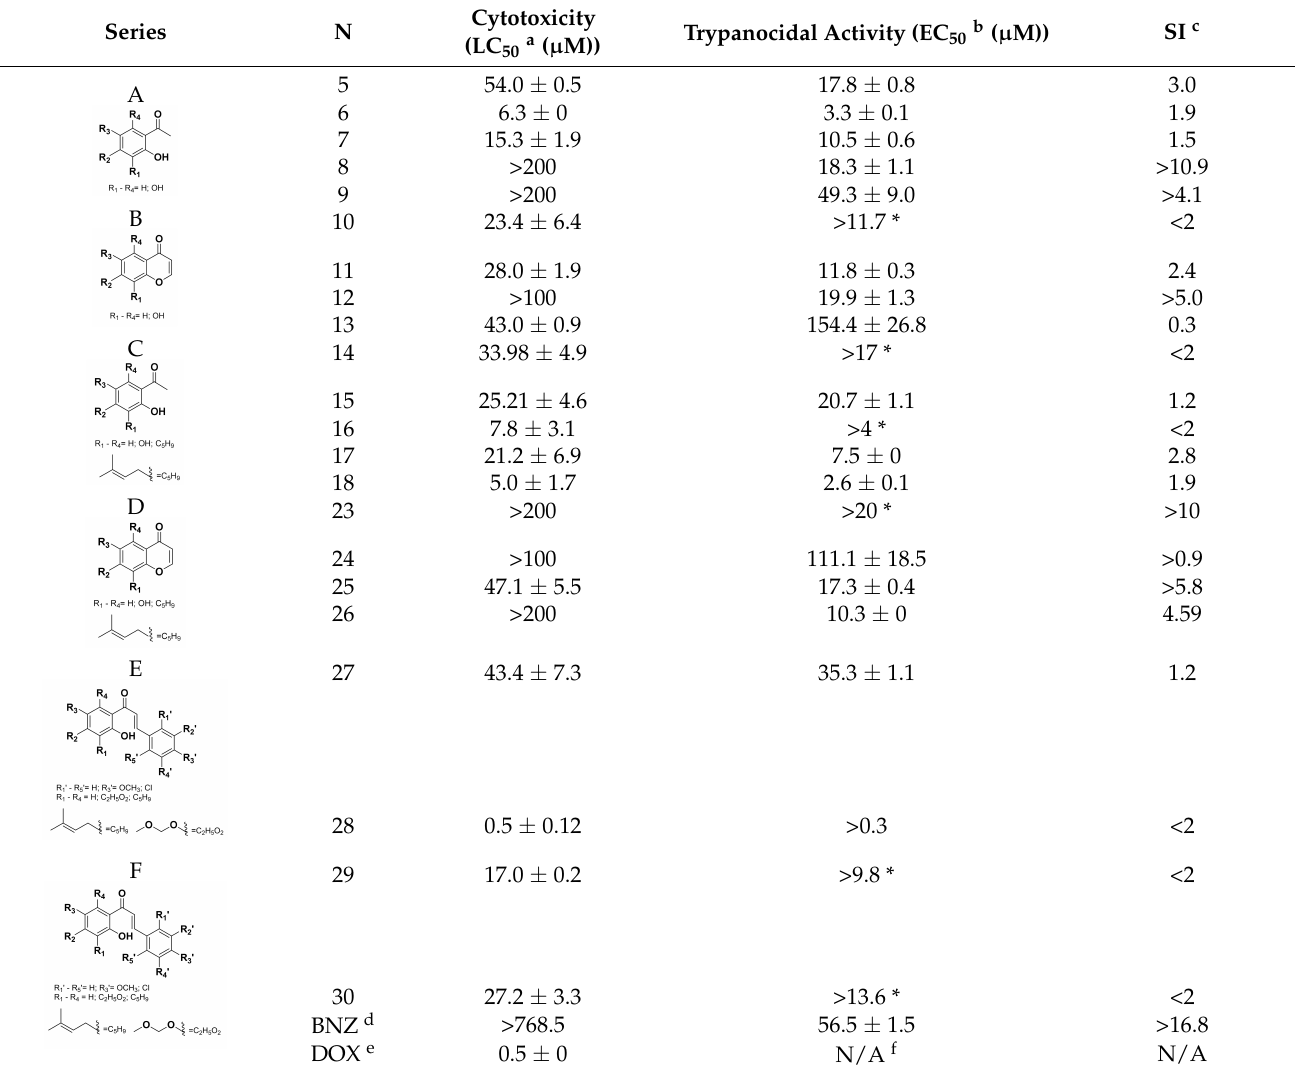
Table 1. In vitro cytotoxicity and antiparasitic